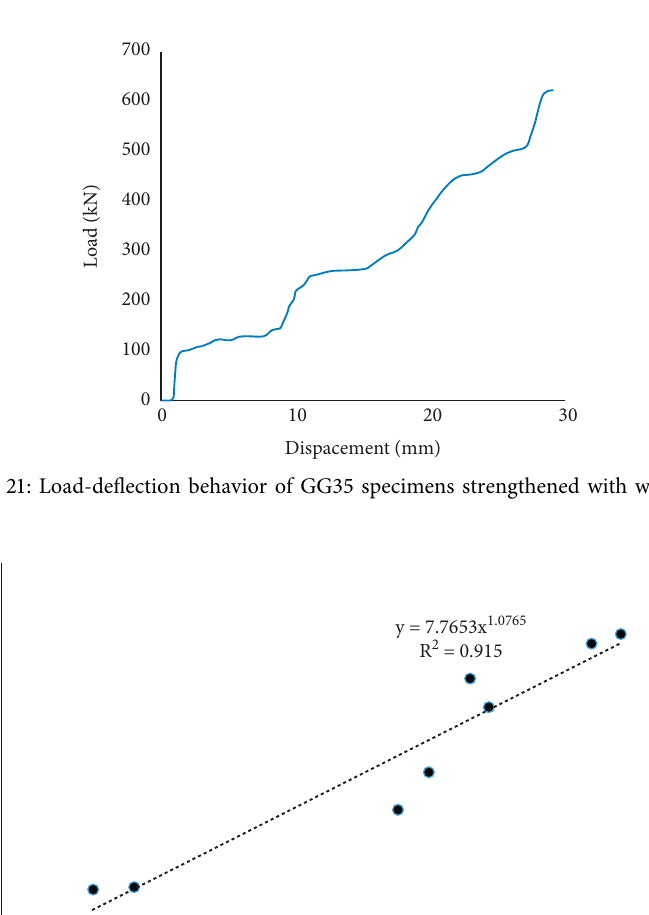
Figure 20: Load-deflection behavior of GG25 specimens strengthened with wrapping.